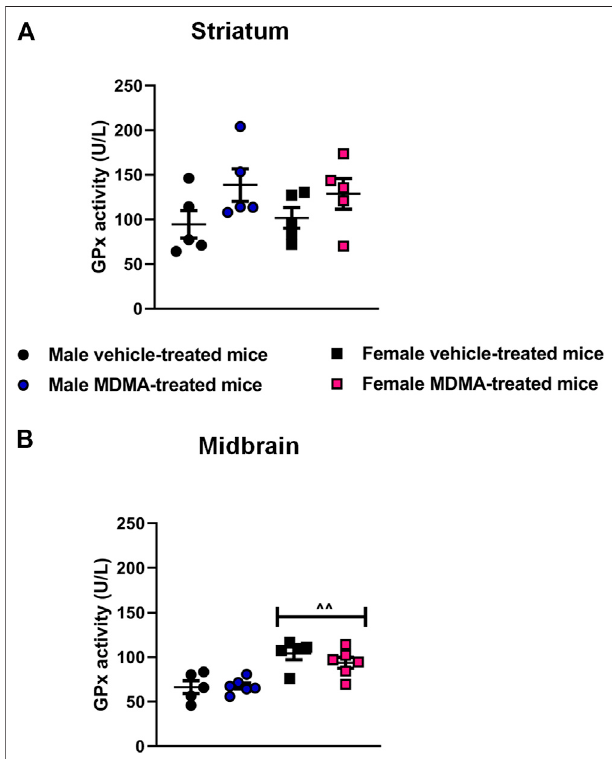
FIGURE 5 | Effects of treatment with MDMA on the glutathione peroxidase (GPx) activity in the striatum (A) and midbrain (B) . Adult male and female mice were treated with either MDMA (4 × 20 mg/kg, i. p. 2 h apart) or vehicle (saline solution, i. p.). N (cid:2) 5 – 6 mice per group. Values are reported as mean ± S.E.M. ∧∧ p < 0.01 compared with the respective groups of male mice, by Newman-Keuls post-hoc test.